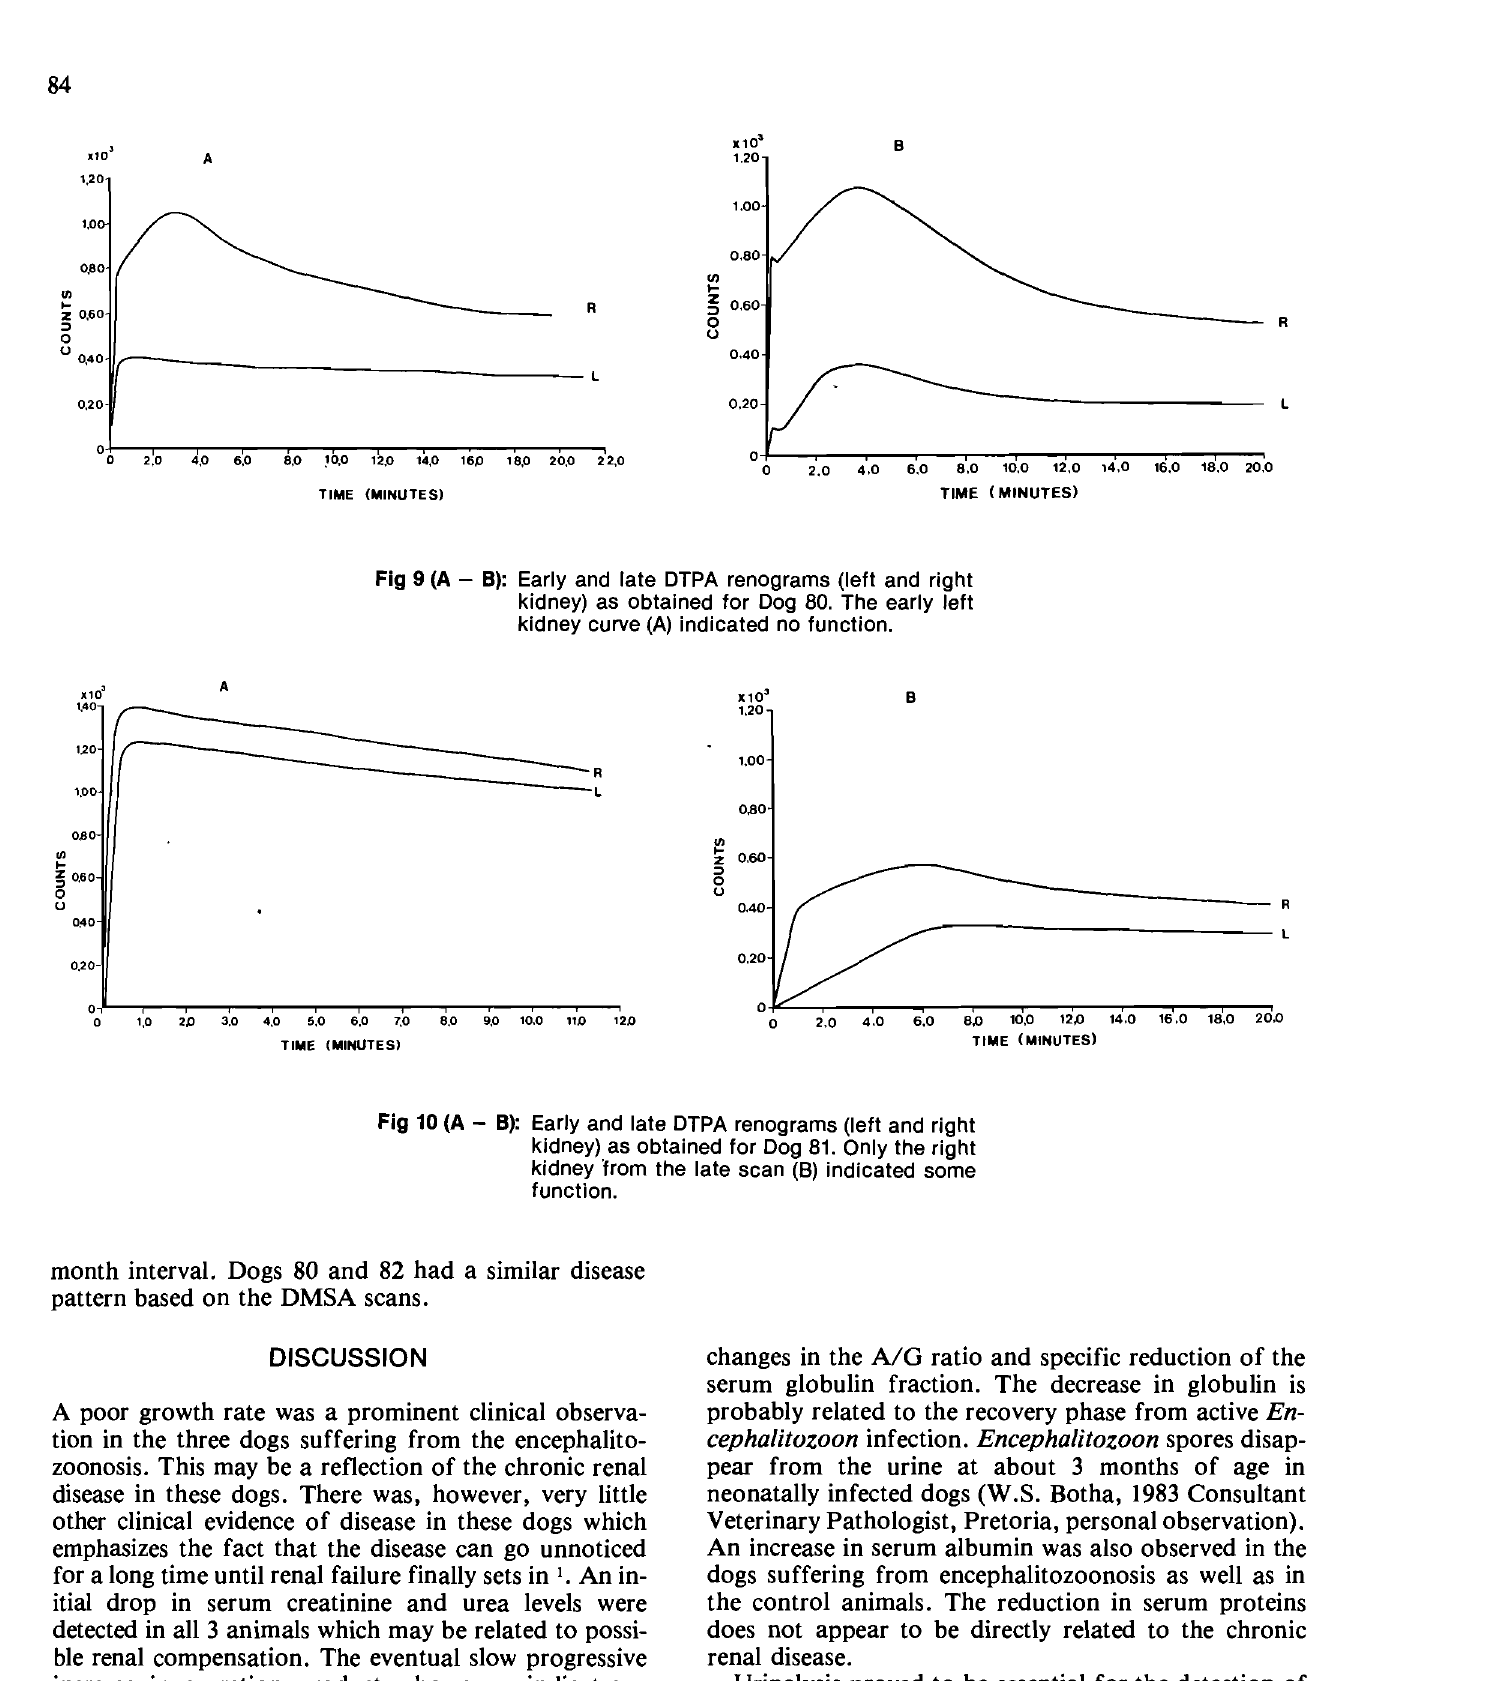
Fig 9 (A - B): Early and late DTPA renograms (left and right kidney) as obtained for Dog 80. The early left kidney curve (A) indicated no function.